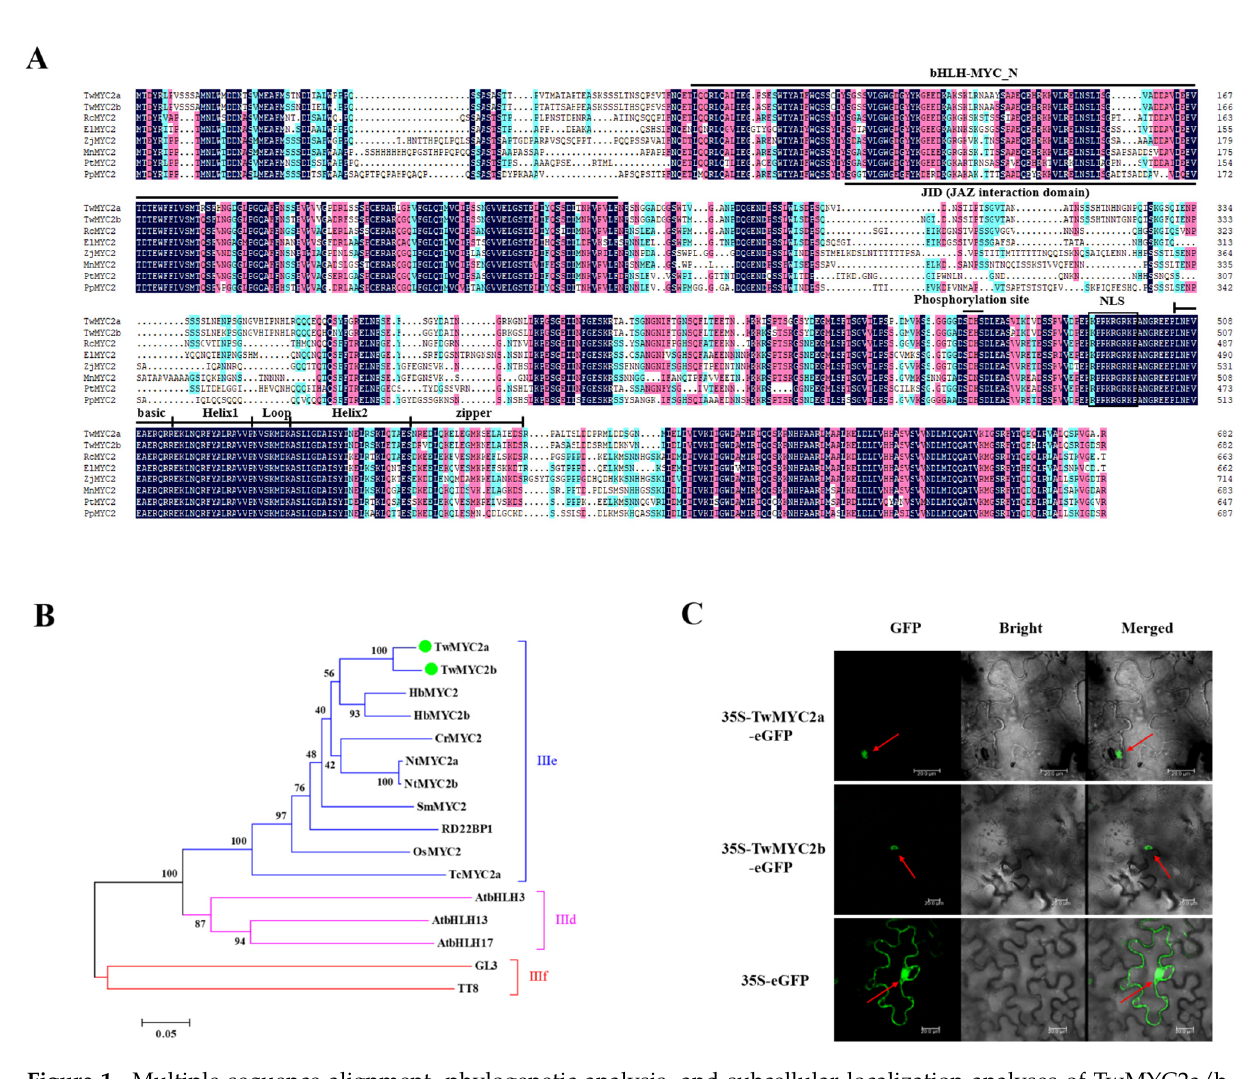
proteins in tobacco ( Nicotiana benthamiana ). TwMYC2a/b fused in-frame with an enhanced green fluorescent protein (eGFP) was transiently expressed in tobacco leaf cells. The empty vector 35S::eGFP was used as a control. The red arrows indicate the location of the nucleus. Scale bars are 20 µ